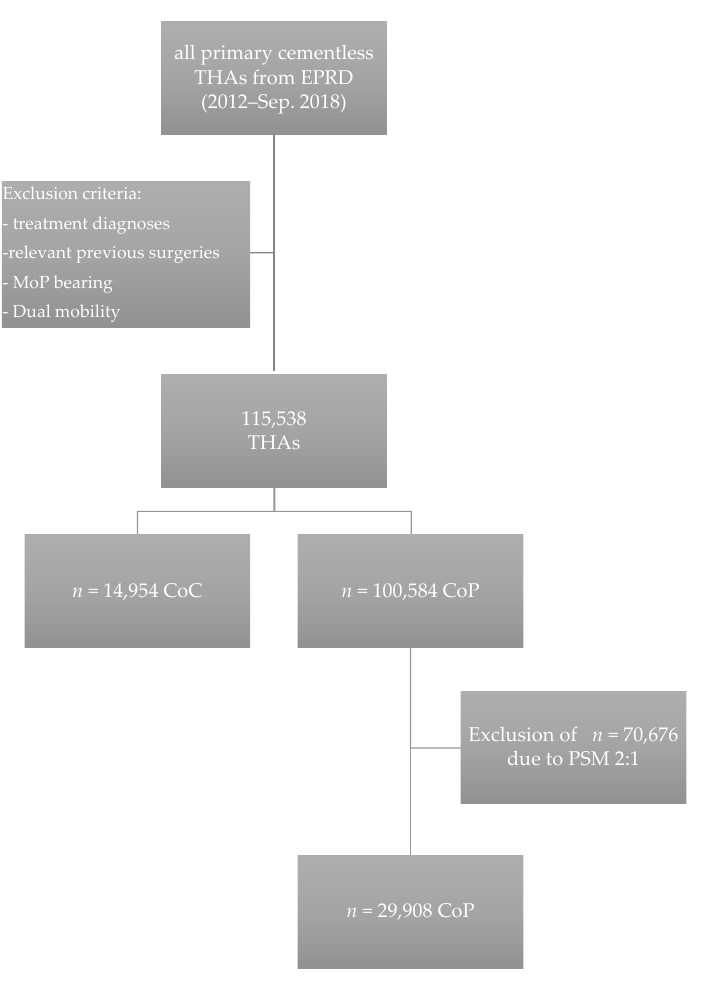
Figure 1. Flowchart illustrating the data acquisition within the German Arthroplasty Registry (EPRD) as well as 1:2 matching using the propensity score (THA, total hip arthroplasty; EPRD, German Arthroplasty Registry; MoP Metal-on-Polyethylen; CoC, Ceramic-on -Ceramic; CoP, Ceramic-on-Polyethylene; PSM, Propensity Score Matching).